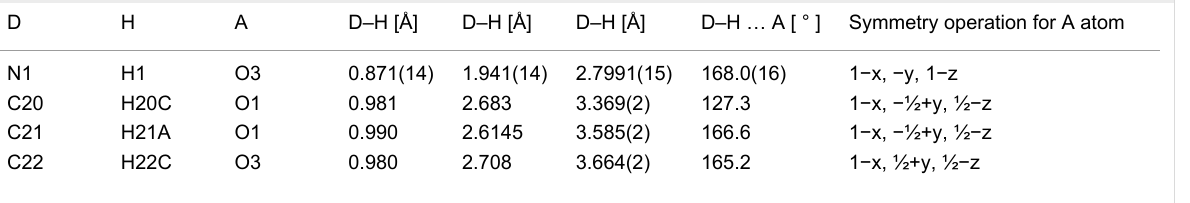
Table 4: Selected hydrogen bonds in the crystal structure of 3a .